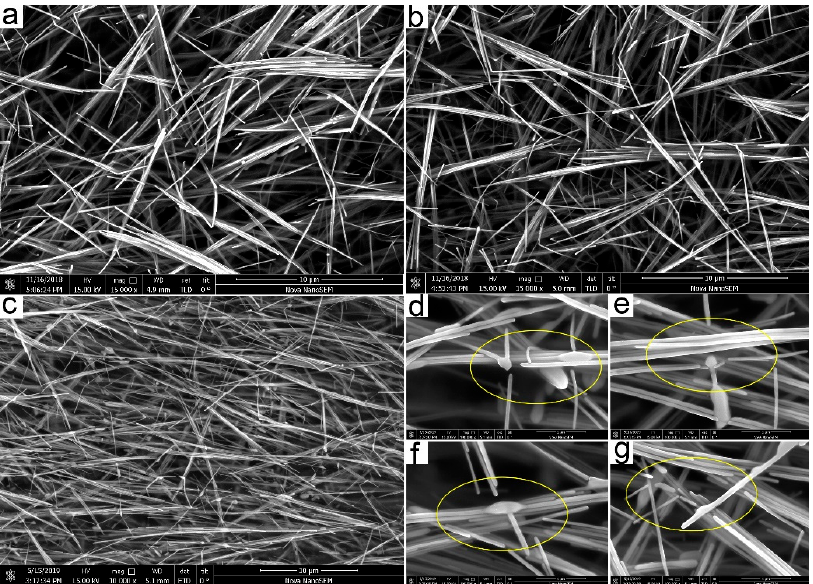
Figure 4. SEM images of the ECAs filled with 30 wt% silver nanowires before ( a ) and after ( b ) being heated at 180 °C for 20 min in a vacuum oven. ( c ) SEM image of the ECAs cured at 250 °C for 20min. ( d–g ) Localized magnified SEM images of sintering and fracture in the silver nanowires shown in ( c ). After confirming that the as-prepared ECAs were fully cured at room temperature, we